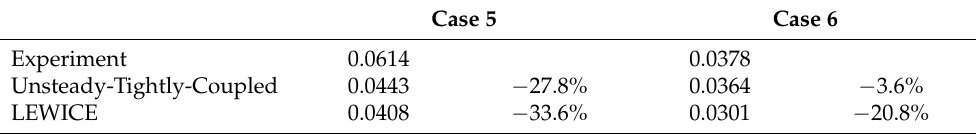
Figure 17. Ice shapes of SLD cases. Table 7. Stagnation thickness of SLD